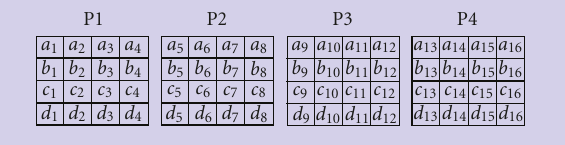
Figure 6: A distributed GOF (four frames) over four processors (P1, P2, P3,